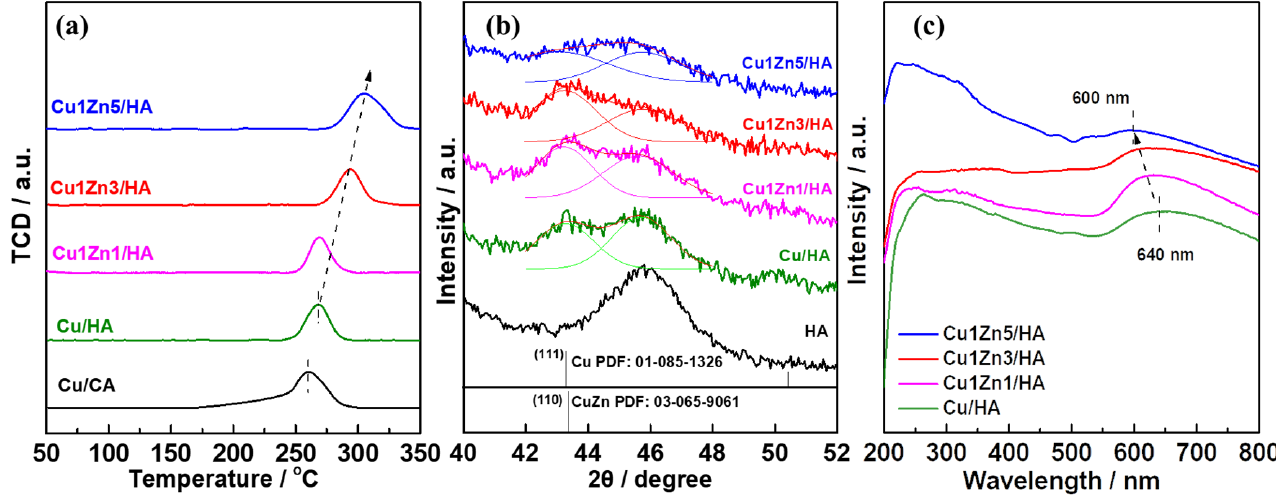
Figure 3. ( a ) Temperature programmed reduction of Cu–Zn/Al 2 O 3 ; ( b ) XRD of Cu–Zn/Al 2 O 3 after reduction at 350 °C for 2 h; ( c ) UV–visible spectra of the calcined-reduced Cu–Zn/Al 2 O 3 samples with Al 2 O 3 as baseline.